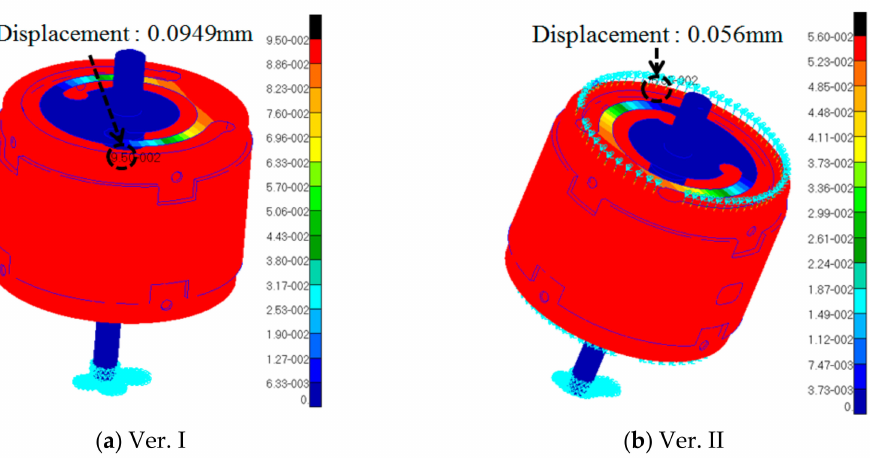
Figure 9. Displacement distribution of VEH via static FE